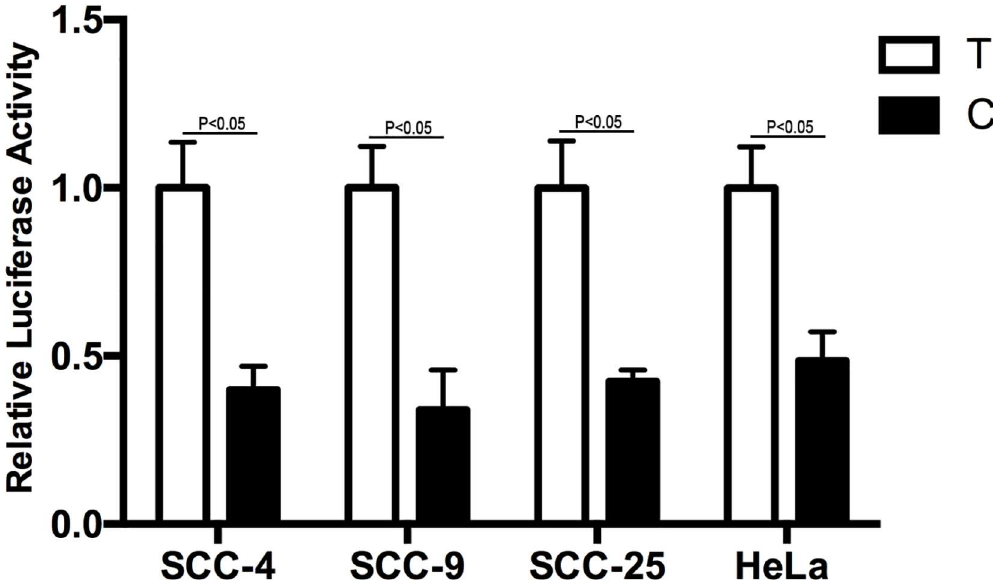
Fig 2. Effectof rs10817938 polymorphism on XPA promoter activity; Schematic representationof reporter plasmidscontaininga T or C alleleat rs10817938,which was inserted upstreamof the luciferasereporter genein the pGL3Basic plasmid. pRL-SV40were co-transfected into SCC-4,SCC-9,SCC-25,HeLa cells as an internalcontrolof Renilla luciferase .Columnsare means fromthreeindependent experiments and bars are standarddeviations.